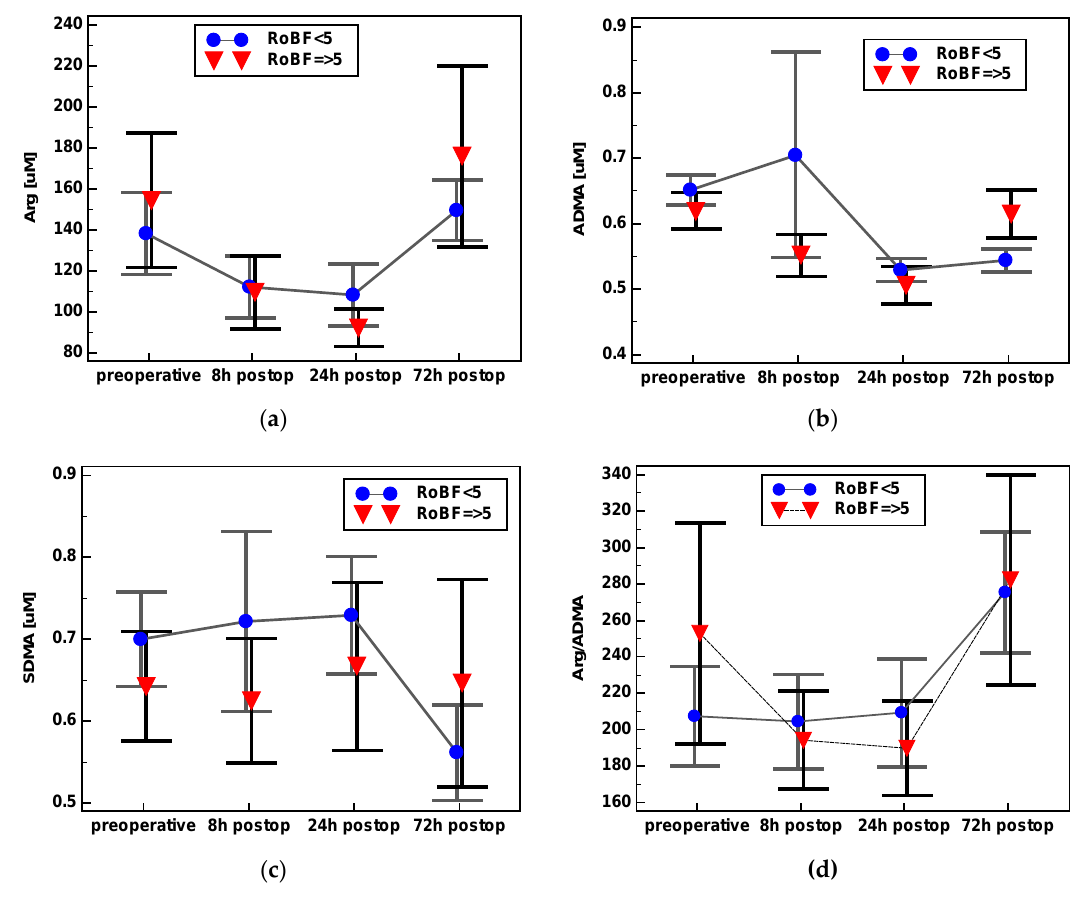
Figure 12. Association of delayed restoration of bowel function (RoBF ≥ 5 days) on postoperative dynamics of L-arginine / NO pathway metabolites: ( a ) Arginine—Arg; ( b ) asymmetric dimethylarginine—ADMA; ( c ) symmetric dimethylarginine—SDMA; ( d ) Arg / ADMA. Data presented as means with a 95% confidence interval and analyzed using repeated measures ANOVA. Postop: